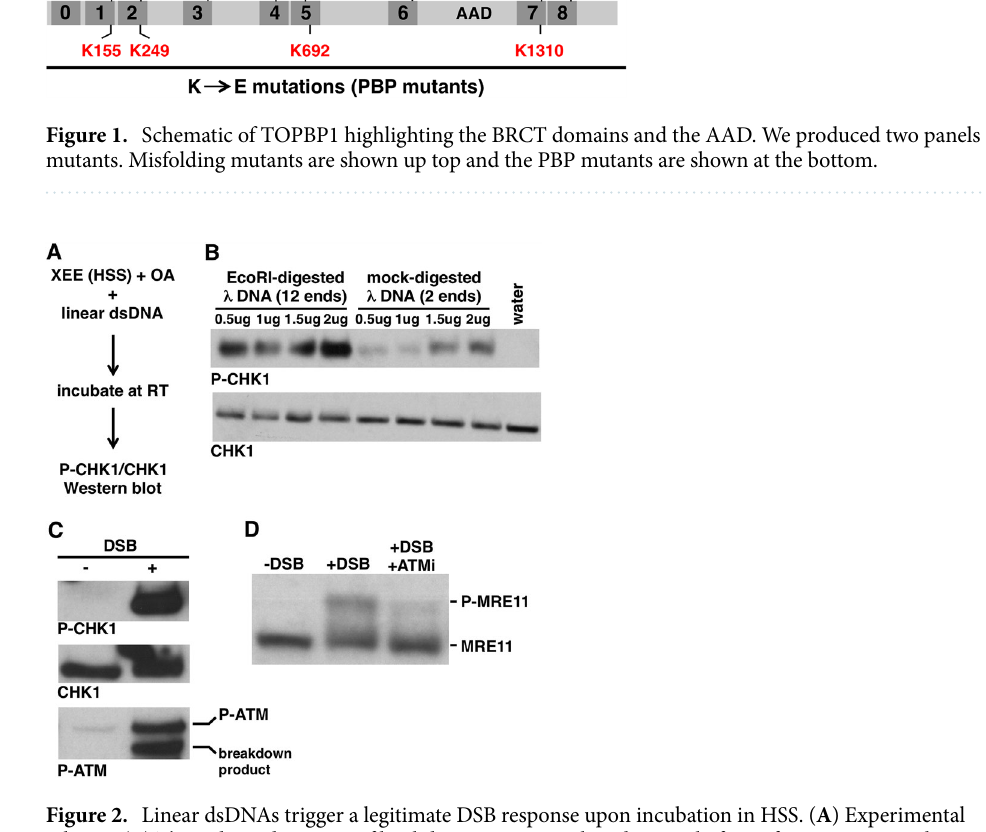
Figure 2. Linear dsDNAs trigger a legitimate DSB response upon incubation in HSS. ( A ) Experimental scheme. ( B ) The indicated amount of lambda DNA was incubated in 20 μl of HSS for 60 min. Samples were then probed by Western blot for P-CHK1 and CHK1. The sample labeled “water” did not receive any DNA. ( C ) 4 µg of EcoRI-digested lambda DNA (“DSB”) was optionally added to 20 μl of HSS and samples were processed as in ( A ). Samples were then probed for P-CHK1, CHK1, and P-ATM (P-Ser1981). ( D ) Either DMSO (lanes 1 and 2) or ATMi (KU55933, 50 µM, lane 3) was added to HSS, which was then optionally supplemented with EcoRI- digested lambda DNA (“DSB”). Samples were processed as in ( A ) and then probed for